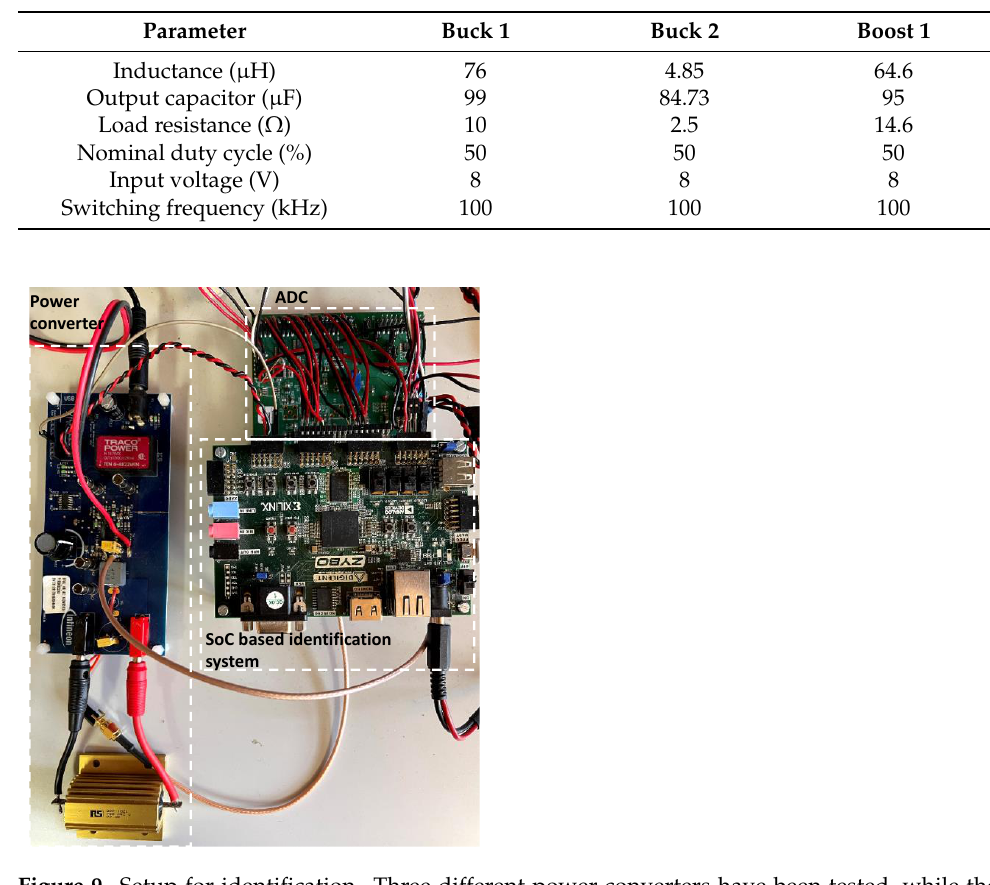
Figure 9. Setup for identification. Three different power converters have been tested, while the digital control card based on an SoC is the same for all tests.